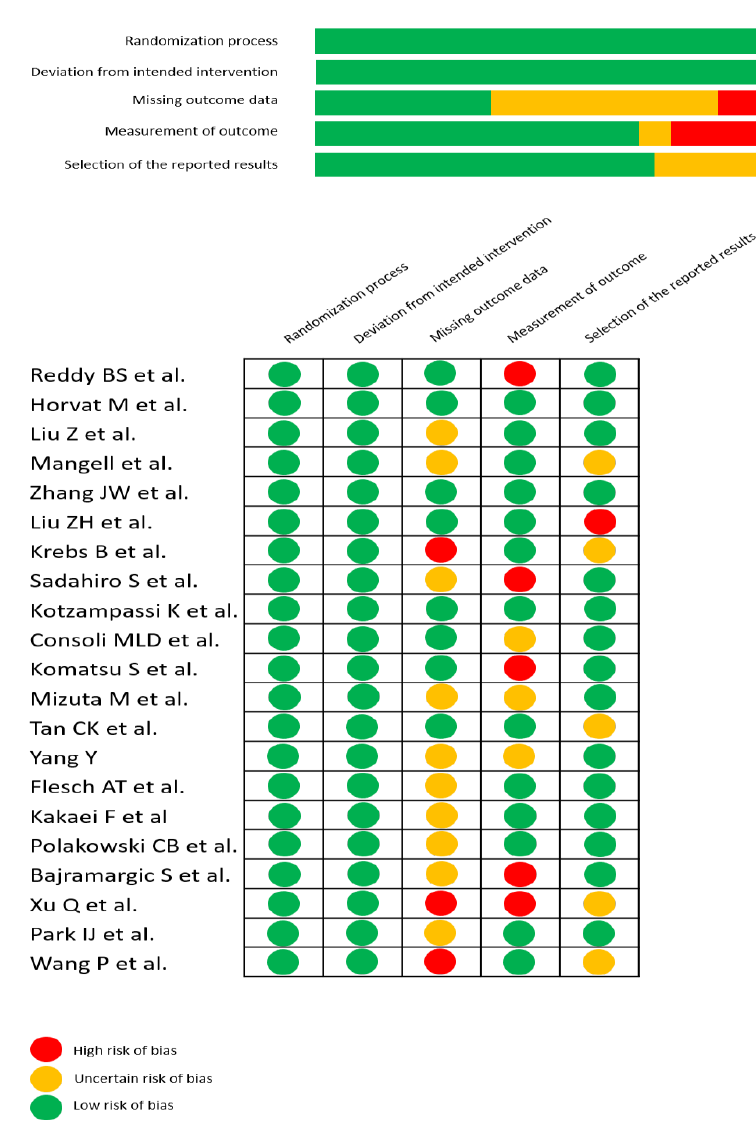
Figure 8. Certainty of evidence according to GRADE [24 – 44]. Table 3. Summary of findings: Quality of evidence according to GRADE.